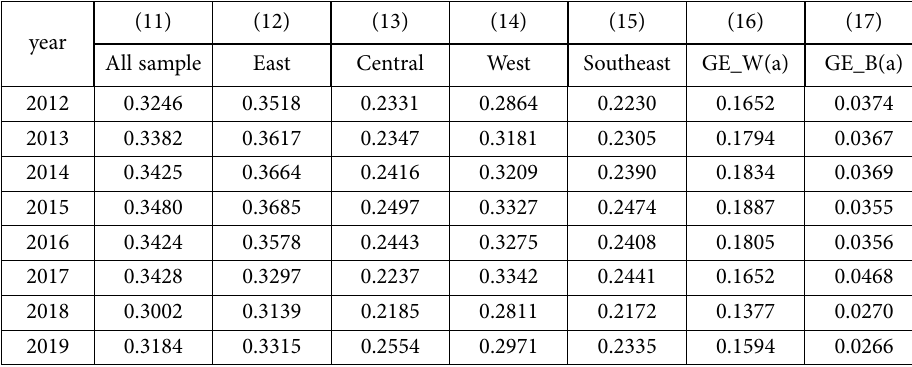
Table 7. The robustness test estimation of the Gini coefficients